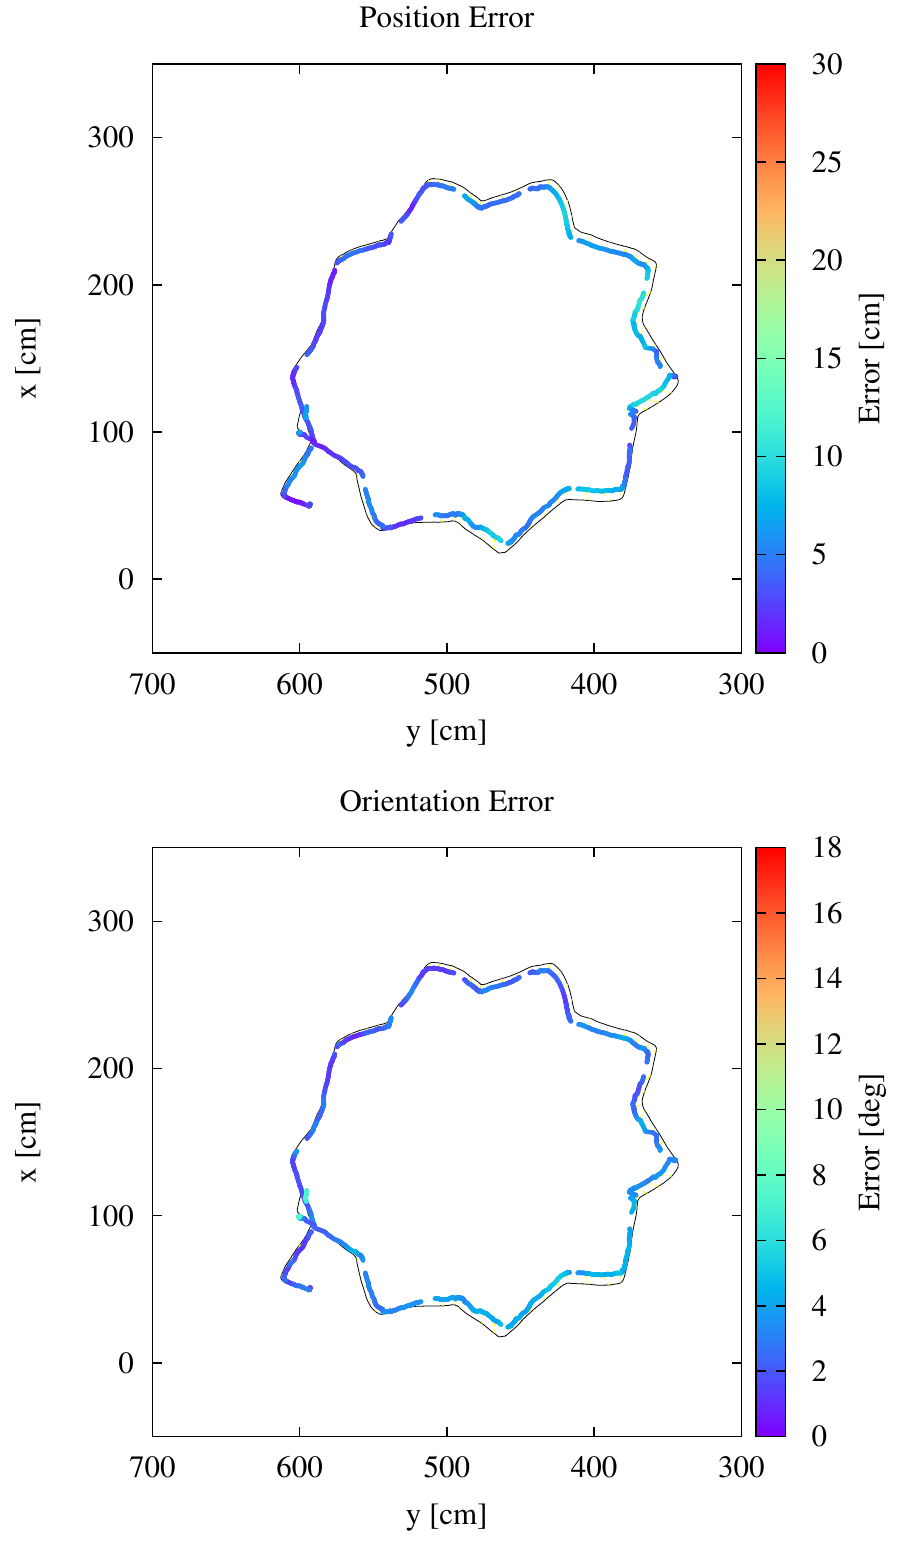
Figure 15. Experiment 3. ( Top ): position error. ( Bottom ): orientation